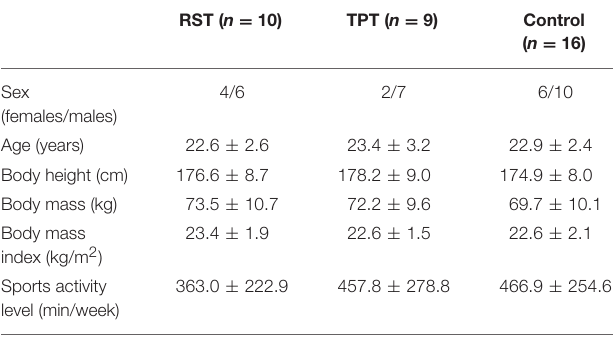
TABLE 1 | Baseline demographic characteristics of the